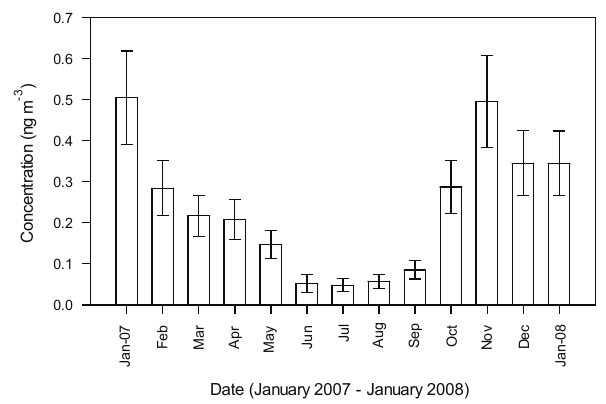
Fig. 2. Monthly average concentrations of benzyl sulfate in PM 2 . 5 in Lahore, Pakistan, determined by UPLC/TQ MS by the method of external calibration. Error bars show the estimate of analytical uncertainty.